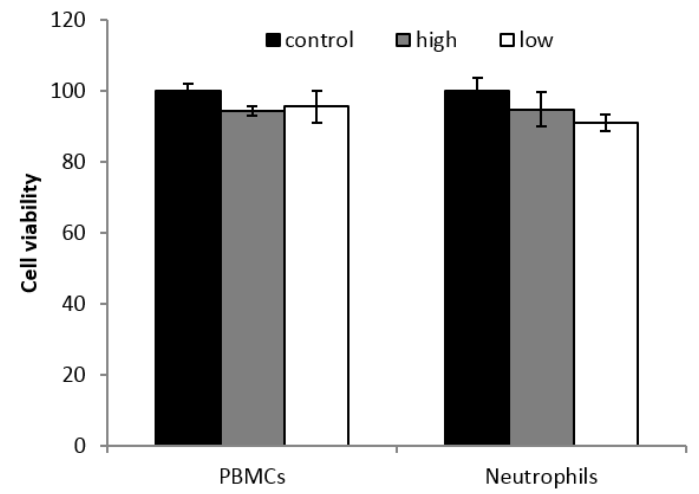
Figure 2. Peripheral blood mononuclear cells (PBMCs) and neutrophils viability after 2 h of exposure to a high and low dosage of H 2 O 2 at 37 ◦ C. Statistical analysis: One way ANOVA, p < 0.05. PBMCs: 1 and 0.1 µ g solid GOX/mL (high and low, respectively). Neutrophils: 15 and 5 µ g solid GOX/mL (high and low, respectively). Control: no GOX added.